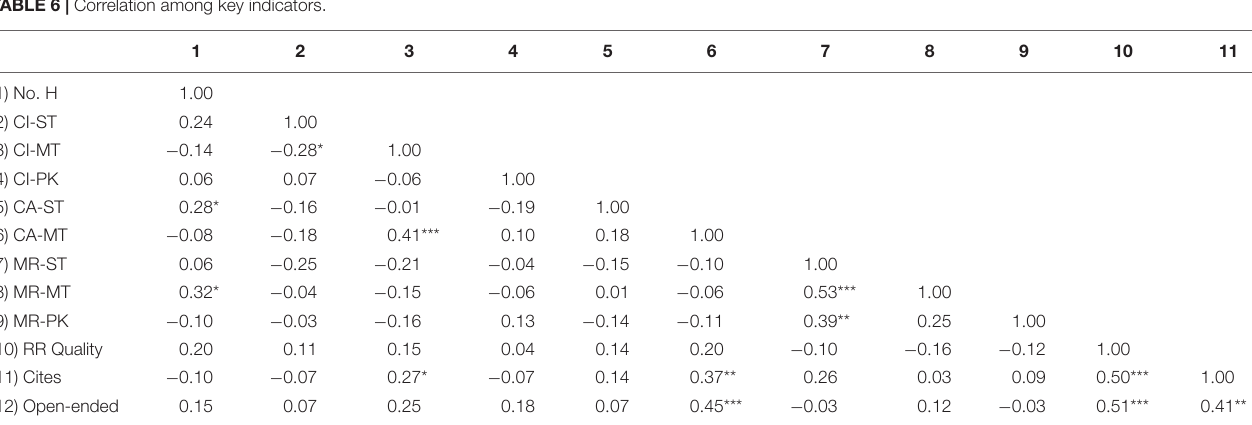
TABLE 6 | Correlation among key